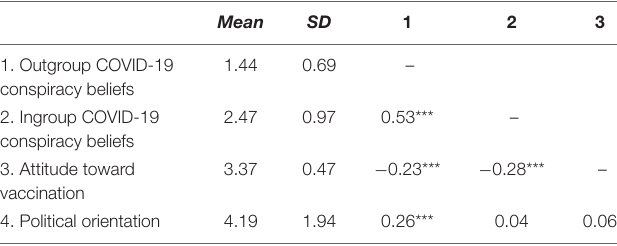
TABLE 1 | Correlations , means, and standard deviations for measured variables (study